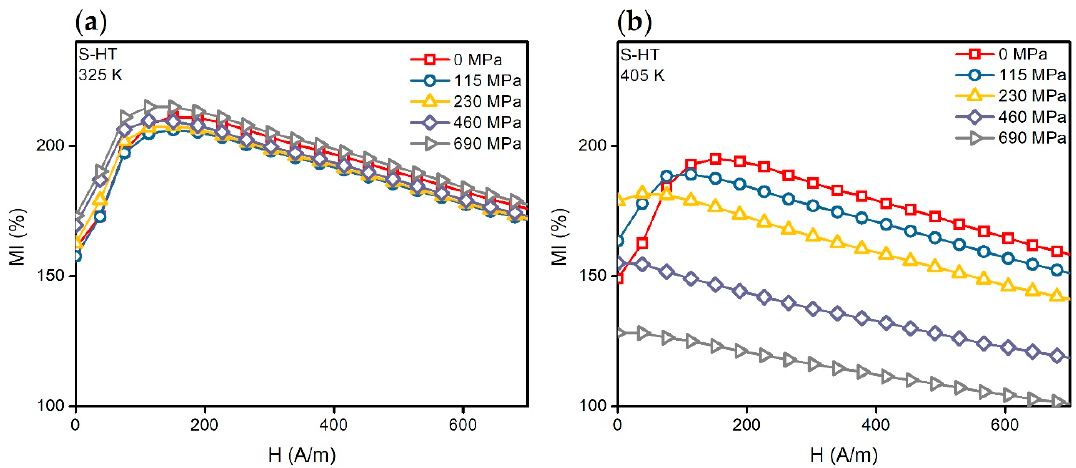
Figure 6. Magnetoimpedance dependencies MI ( H ) of the S-HT amorphous ribbon obtained at the temperatures T = 325 K ( a ) and T = 405 K ( b ). The dependencies are given for the alternating current frequency of 10 MHz and the tensile stresses of 0, 115, 230, 460, and 690 MPa.